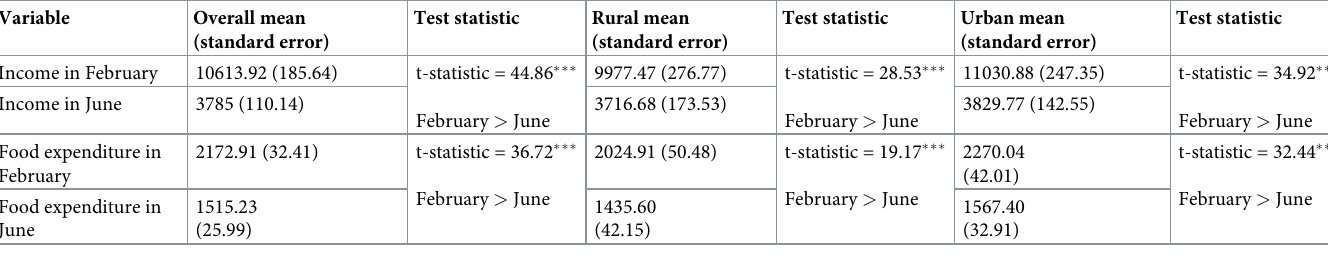
Table 5. Paired t-test for income and food expenditure gaps between February and June